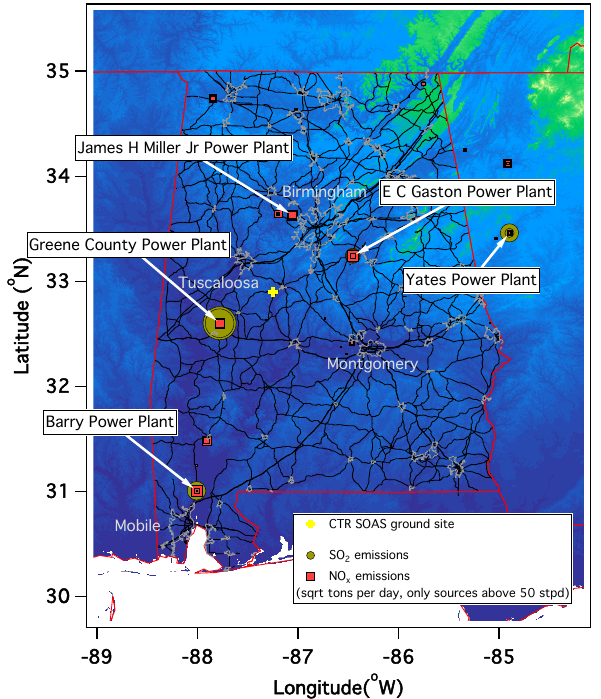
Figure 1. Map of Alabama with SO 2 and NO x emissions point sources shown, as well as major roadways (black). Centreville is lo- cated in Central Alabama about 55 miles SSW of Birmingham, AL. Major highways, city limits and major contributors to emissions are referenced for Alabama. The size of the emission markers depicts the relative concentrations of the pollutants according to the 2013 EPA Air Markets Program in square-root tons per day, and only sources above 50 square-root tons per day are shown. For reference, the Alabama Power Company Gaston Plant emits 19.52kgh − 1 SO 2 and 6.43kgh − 1 NO x .